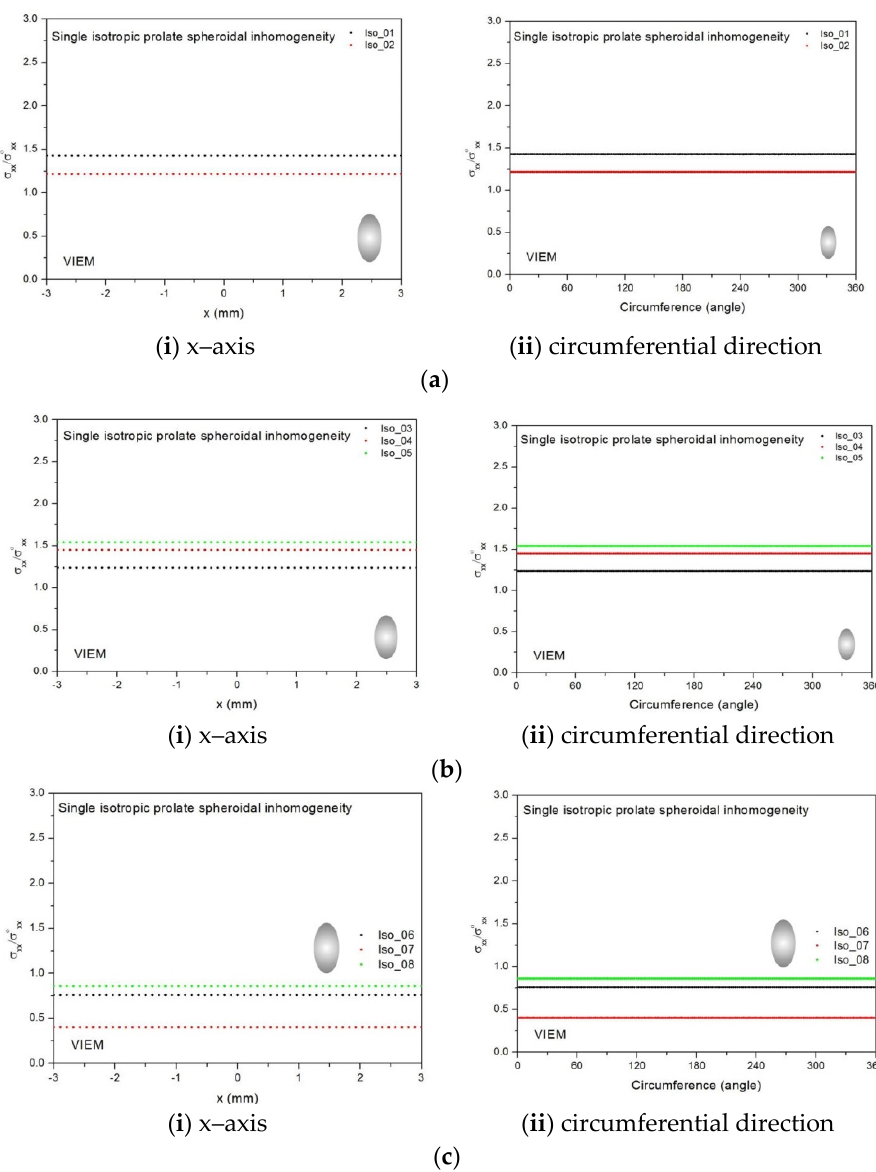
Figure 12. VIEM results for the normalized tensile stress component ( σ xx / σ oxx ) along ( i ) the x–axis inside and ( ii ) the circumferential direction of the isotropic prolate spheroidal inclusions with a/b = c/b = 0.5 (b = 6 mm) under uniform remote tensile loading. ( a ) Iso_01 and Iso_02. ( b ) Iso_03, Iso_04 and Iso_05. ( c ) Iso_06, Iso_07 and Iso_08.